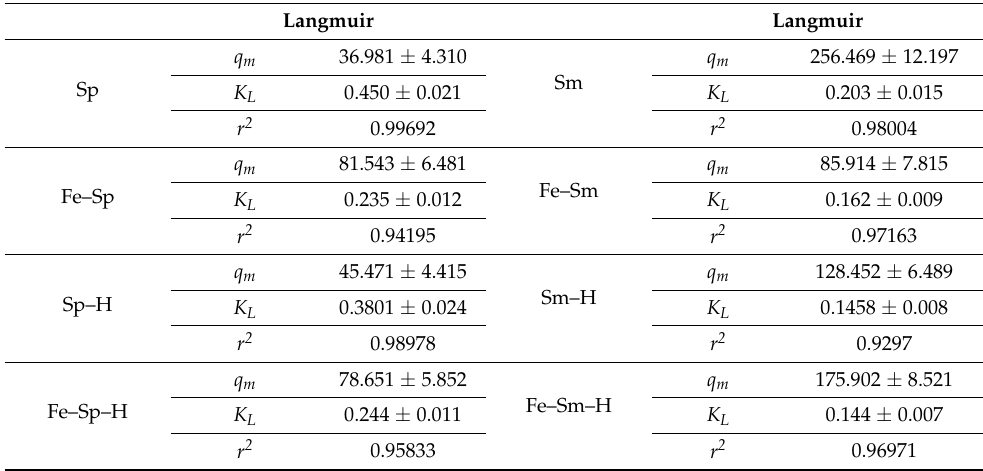
Table 3. Adsorption data obtained from Langmuir Adsorption Isotherm. Langmuir